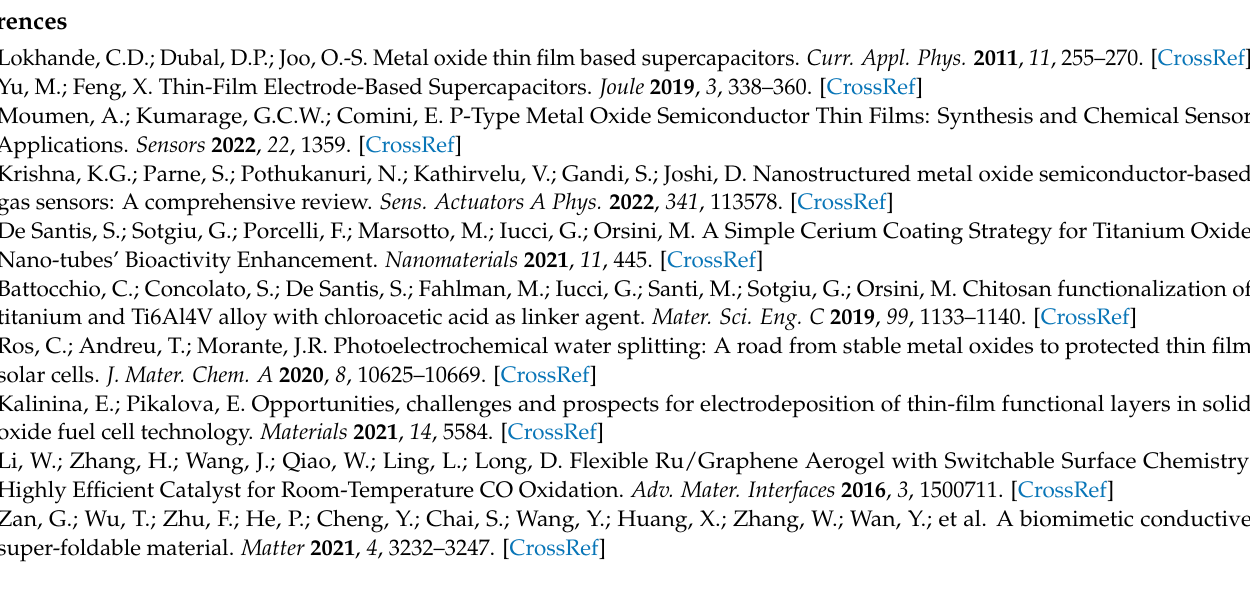
E01. Figure S2. SEM image at larger scale for electrode E02. Figure S3. SEM image at larger scale for electrode E03. Figure S4. SEM image at larger scale for electrode E04. Figure S5. EDS map